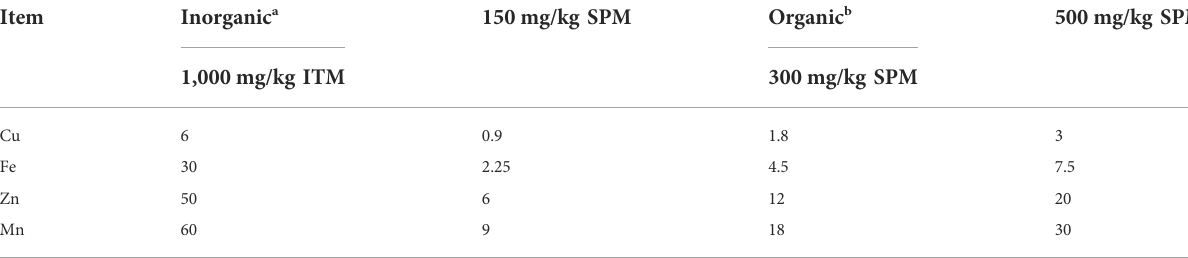
TABLE 2 Experimental treatment of broiler diets and supply of each trace element